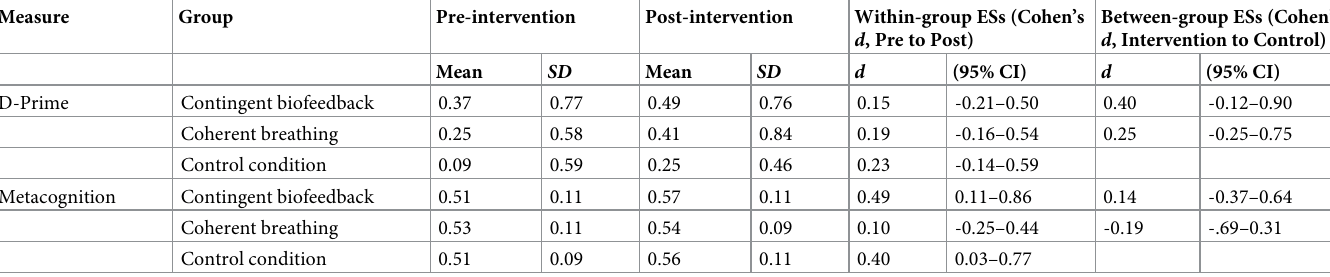
Table 2. Observed means and standard deviations at pre-intervention and post-intervention for the intervention groups. Measure